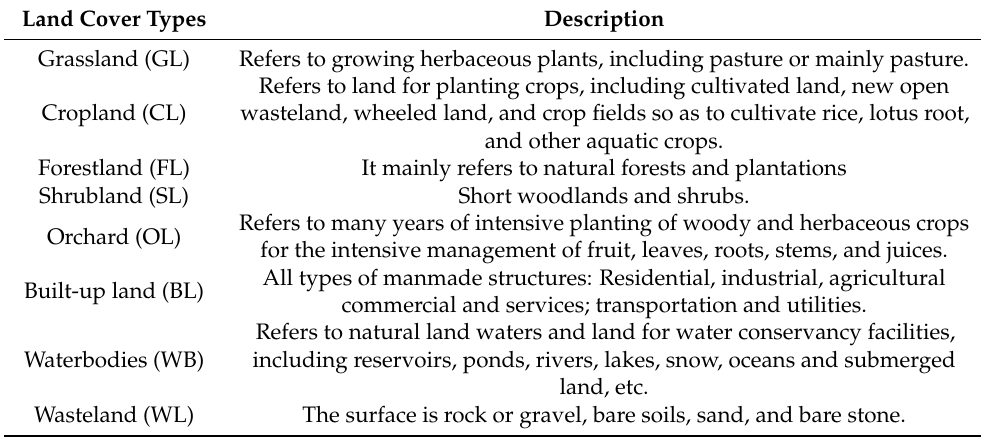
Table 1. Land use types in the study area (based on the Chinese National Standard and Yi)